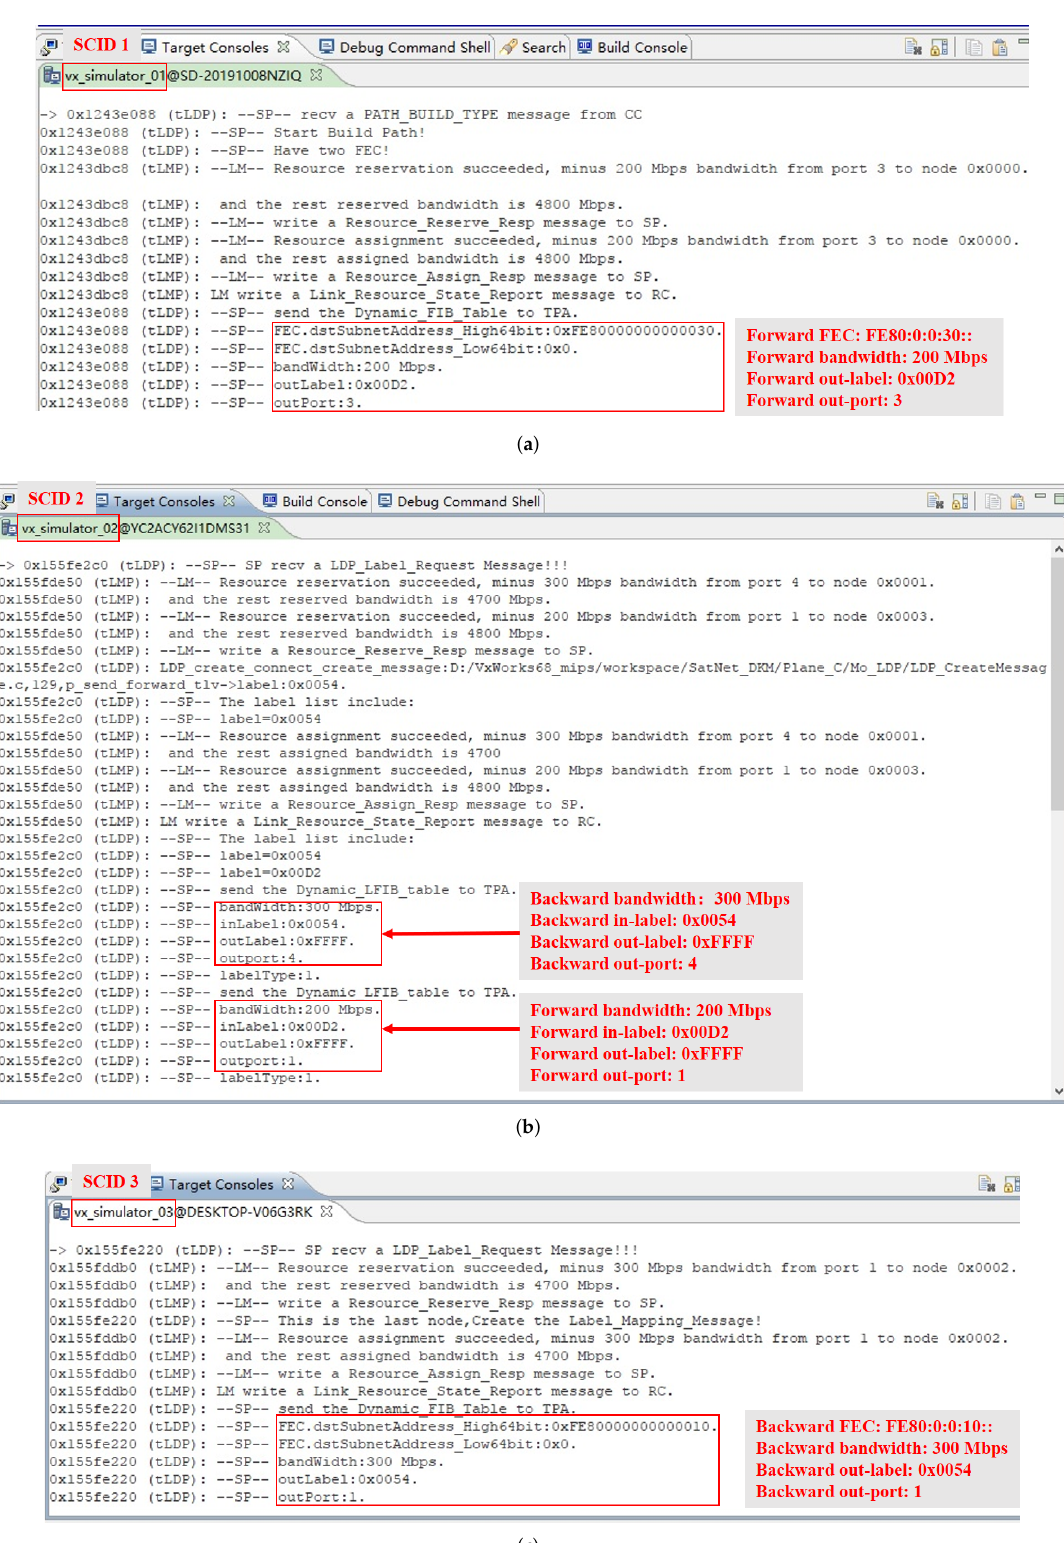
Figure 25. The label distribution process of label switching path setup under QoS requirements and the circumstances of uni-directional link between node vx_simulator_01 (ingress LER, SCID 1), node vx_simulator_02 (LSR, SCID 2), and node vx_simulator_03 (egress LER, SCID 3). ( a ) The label distribution process in node vx_simulator_01 (SCID 1). ( b ) The label distribution process in node vx_simulator_02 (SCID 2). ( c ) The label distribution process in node vx_simulator_03 (SCID